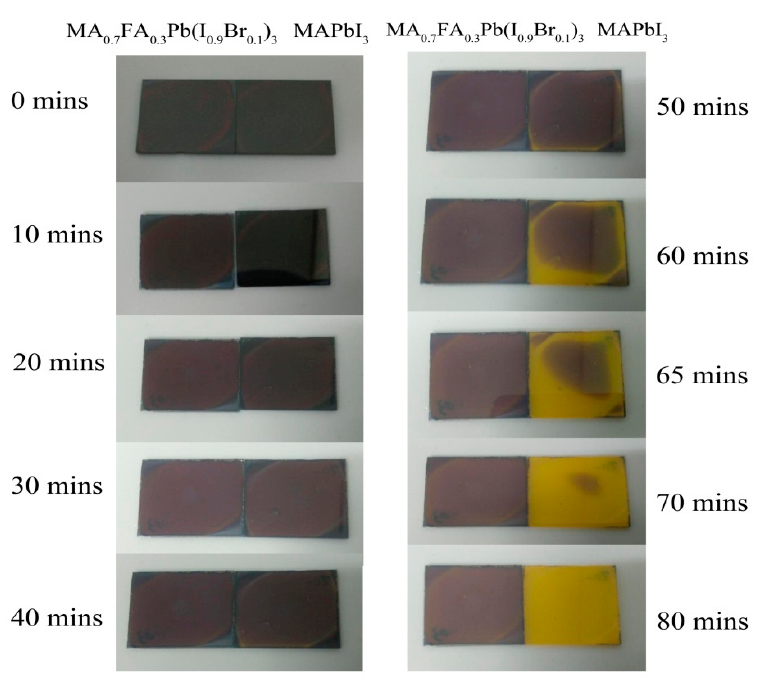
Figure 6. Thermal degradation of MA 0.7 FA 0.3 Pb(I 0.9 Br 0.1 ) 3 and MAPbI 3 films on glass, when each perovskite is heated at 150 °C for the times indicated.